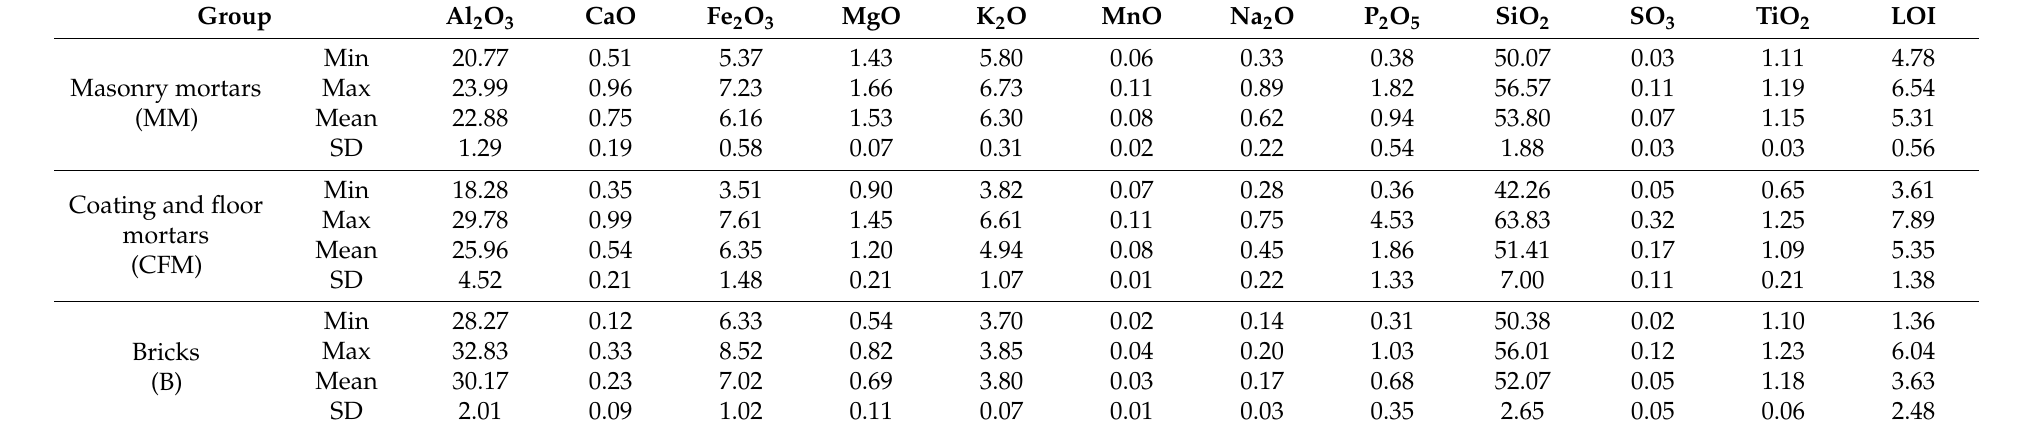
Table 2. Samples major elements chemical composition, in %.